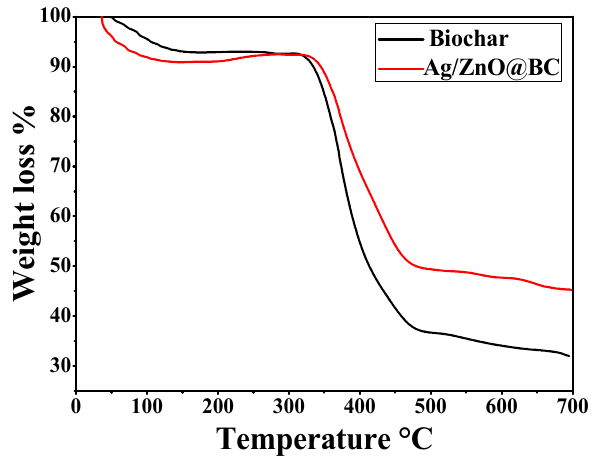
Figure 8. TGA curves of biochar and Ag/ZnO@BC.